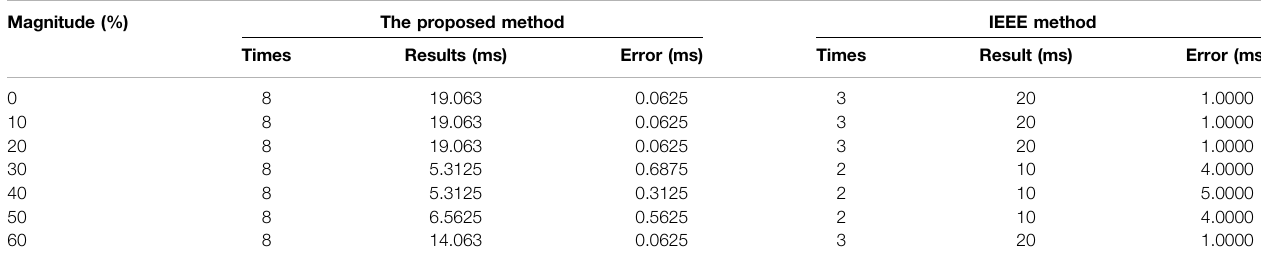
TABLE 5 | Comparisons between the proposed method and the IEEE method. Magnitude (%) The proposed